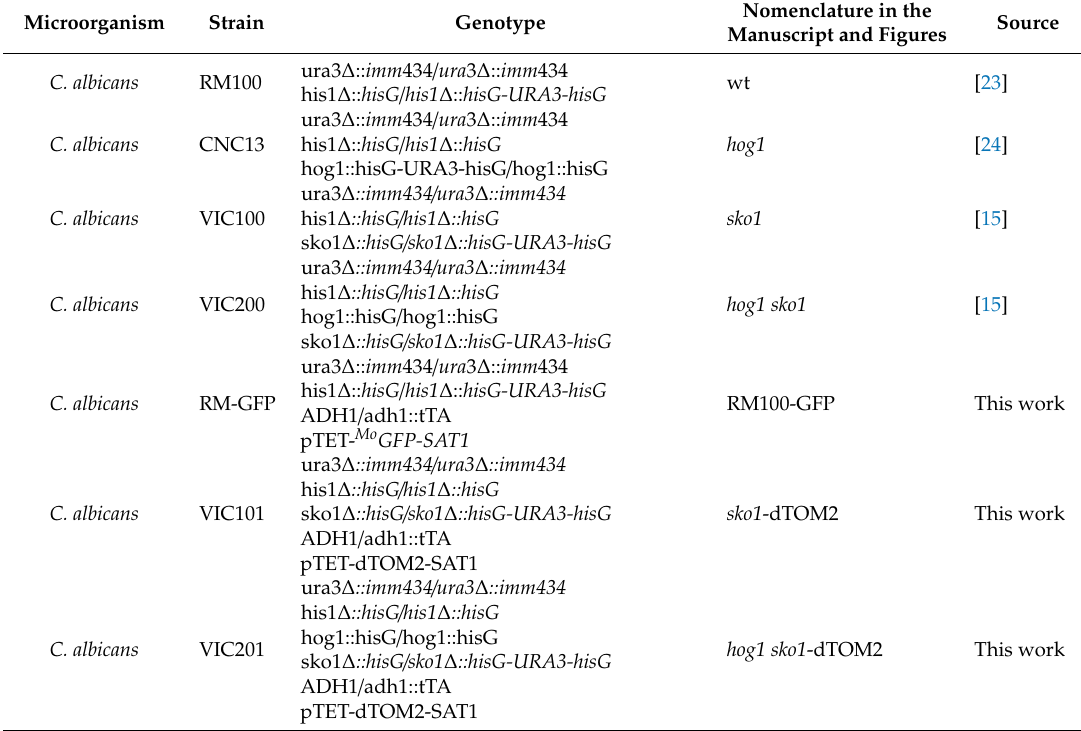
Table 1. Strains that were used in this